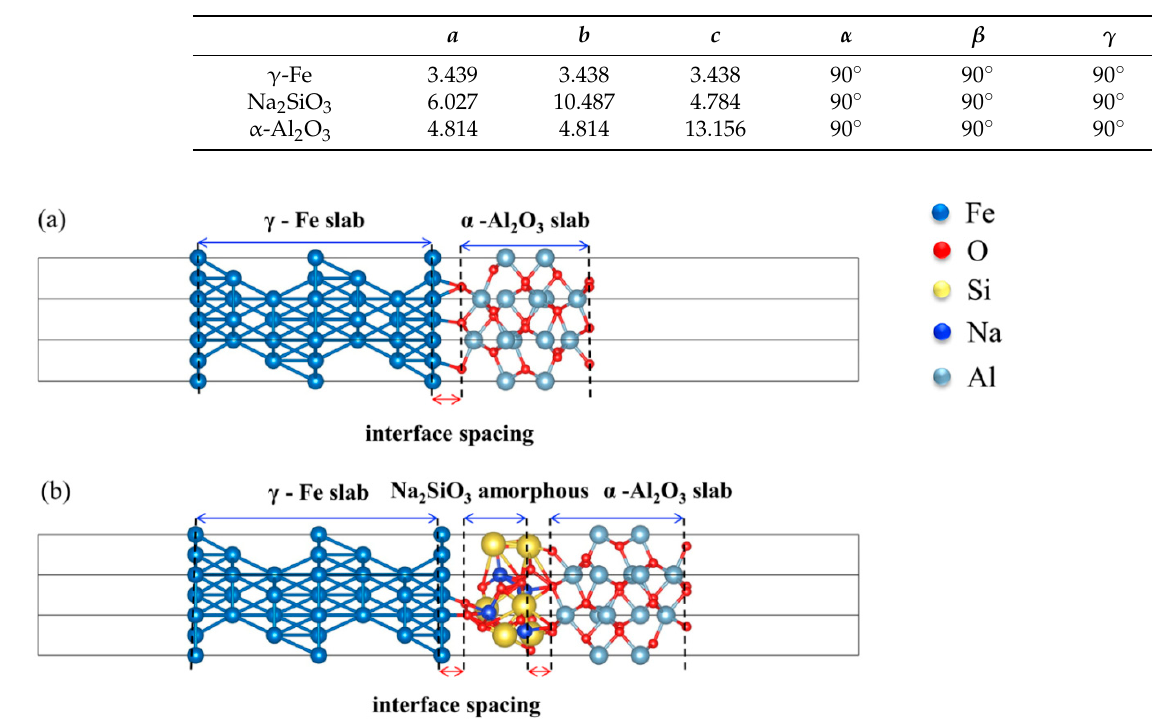
Figure 1. The crystal structure of ( a ) γ -Fe, ( b ) Na 2 SiO 3 , and ( c ) α -Al 2 O 3 . Table 1. The lattice constants of the γ -Fe, Na 2 SiO 3 , and α -Al 2 O 3 bulks.